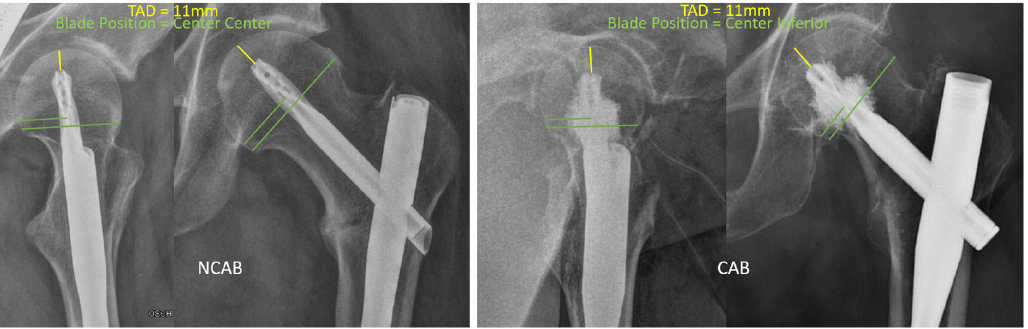
Figure 1. Measurement of the TAD (tip apex distance = yellow lines) and the blade position (position of the blade in the area of the femoral head = green lines). Left side: NCAB; right side: CAB.